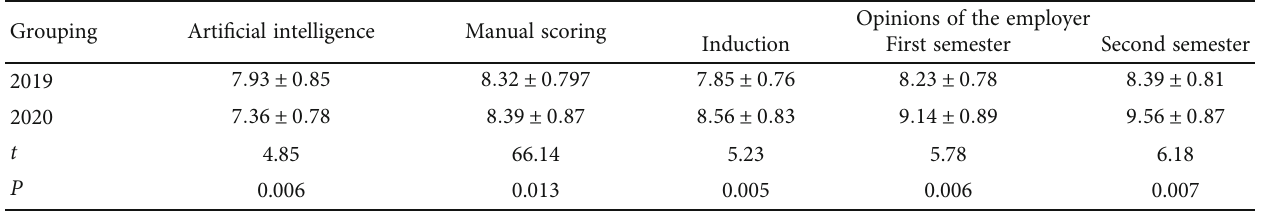
Table 1: Statistics of students ’ aerobic performance (the data comes from the student fi les of the student o ffi ce of our university). Grouping